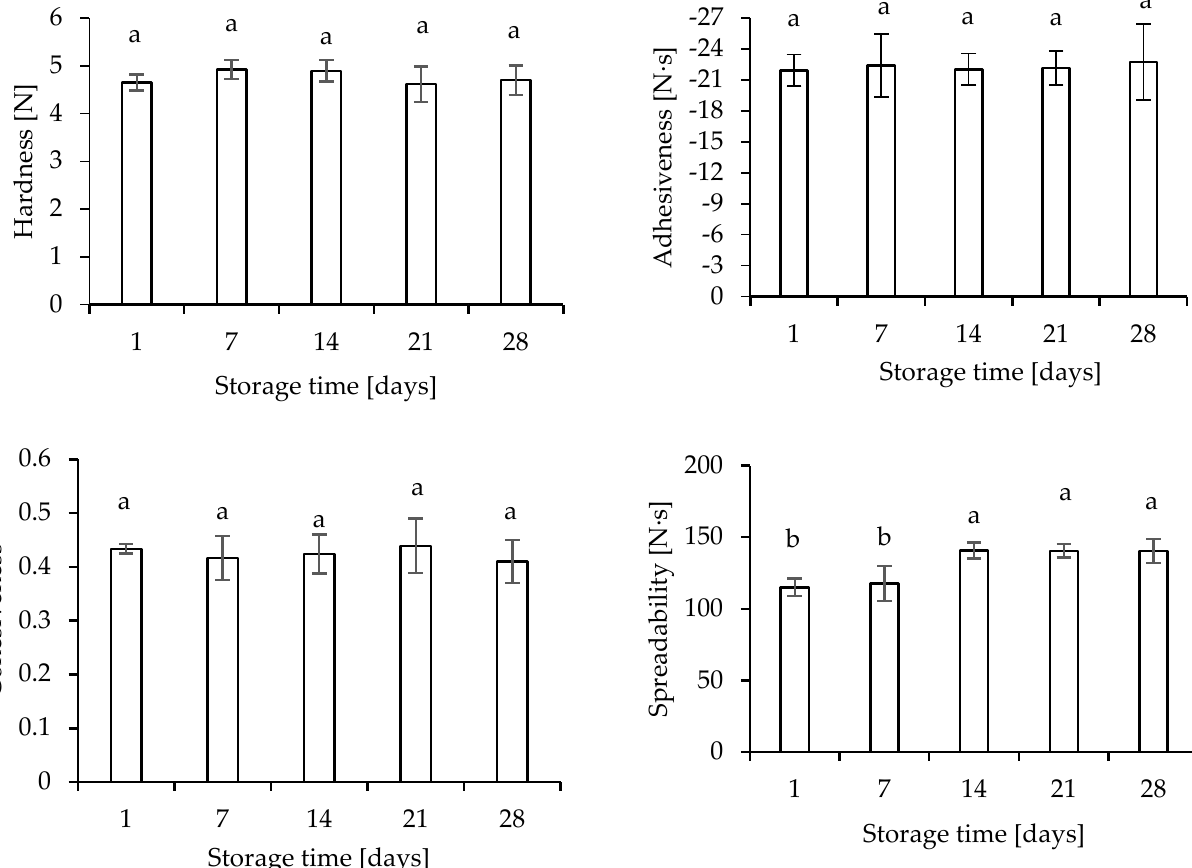
Figure 1. Texture properties of the milk fat- inulin spread. Values are means. Means with different letters for the same texture feature are significantly different ( p ≤ 0.05).